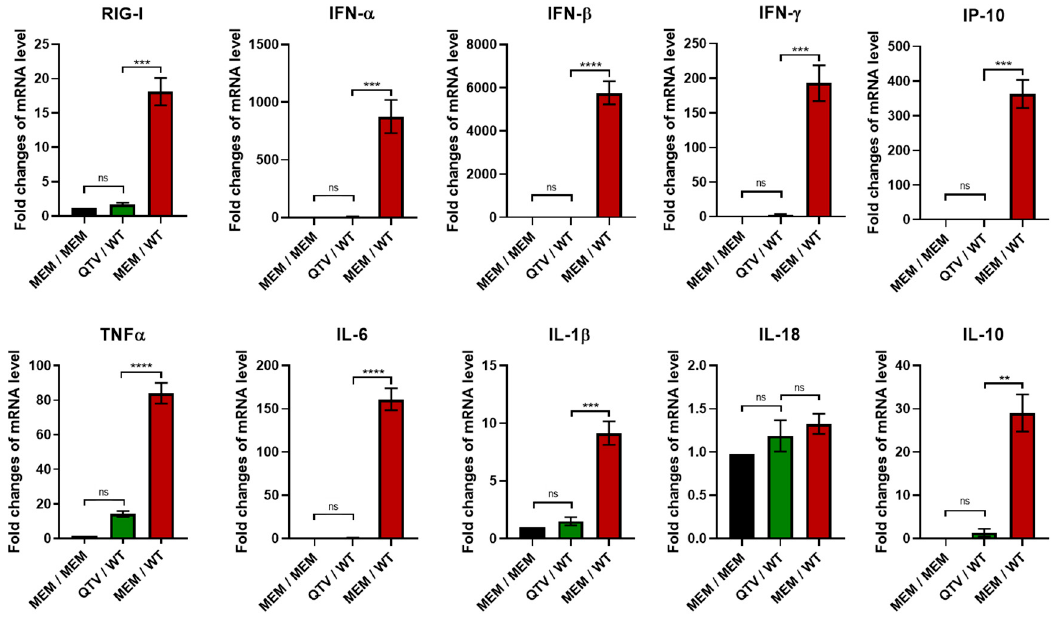
Figure 8. Cytokine production after homologous viral challenge with BC15 (H7N9). The mRNA levels of RIG-I, IFN- α , IFN- β , IFN- γ , IP-10, TNF α , IL-6, IL-1 β , IL-18, and IL-10 were determined from the mouse lungs harvested at three days post-challenge ( n = four mice per group, two males and two females). These levels were assessed by qPCR, where each sample was tested in triplicate. The bars represent the mean value obtained from all mice in the respective group, and the error bar represents the standard deviation. Significant differences among groups are signified by ** ( P < 0.01), *** ( P < 0.001) or **** ( P < 0.0001). ns. = not significant. A one-way ANOVA was performed, which was followed by the Tukey post-hoc test to determine the P -value.